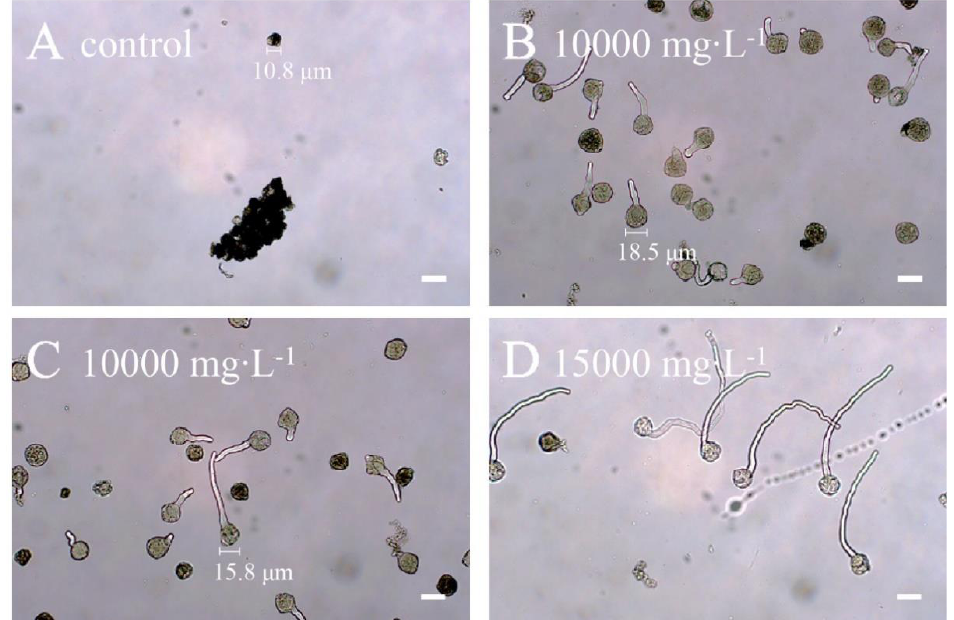
Figure 4. Abnormalities in pollen morphology and germination from ‘103-1’ ( Kalanchoe garambiensis ‘Type 1’ × K. nyikae ) were restored in colchicine-treated ’103-1’ clones. ( A ) No colchicine control ‘103-1’ clone generated pollens with abnormal morphology and no germination observed. ( B , C ) are from two individual 10,000 mg∙L −1 colchicine-treated ’103-1’ clones. Normal morphology and pollen germination were observed with germination percentages of 17.3% and 21.3%, respectively. ( D ) is from a 15,000 mg∙L −1 colchicine-treated ’103-1’ clone with pollen germination percentage at 86.7%. Bar = 20 μm. Sizes of selected pollen grains were labelled in each panel.